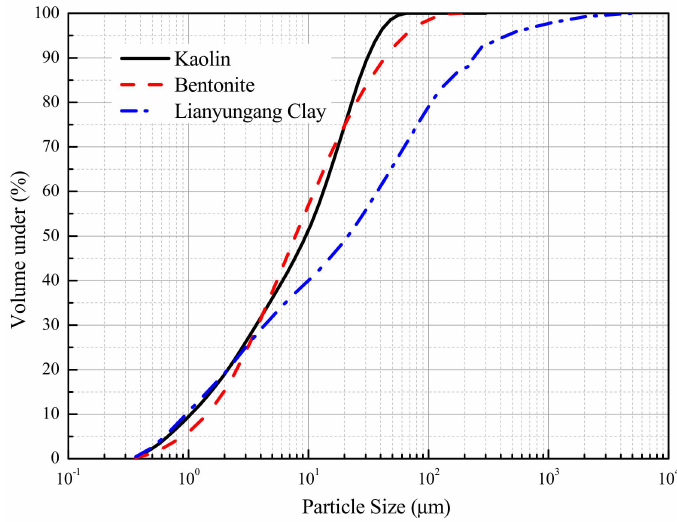
Figure 1. Particle size distribution curves of the considered materials.